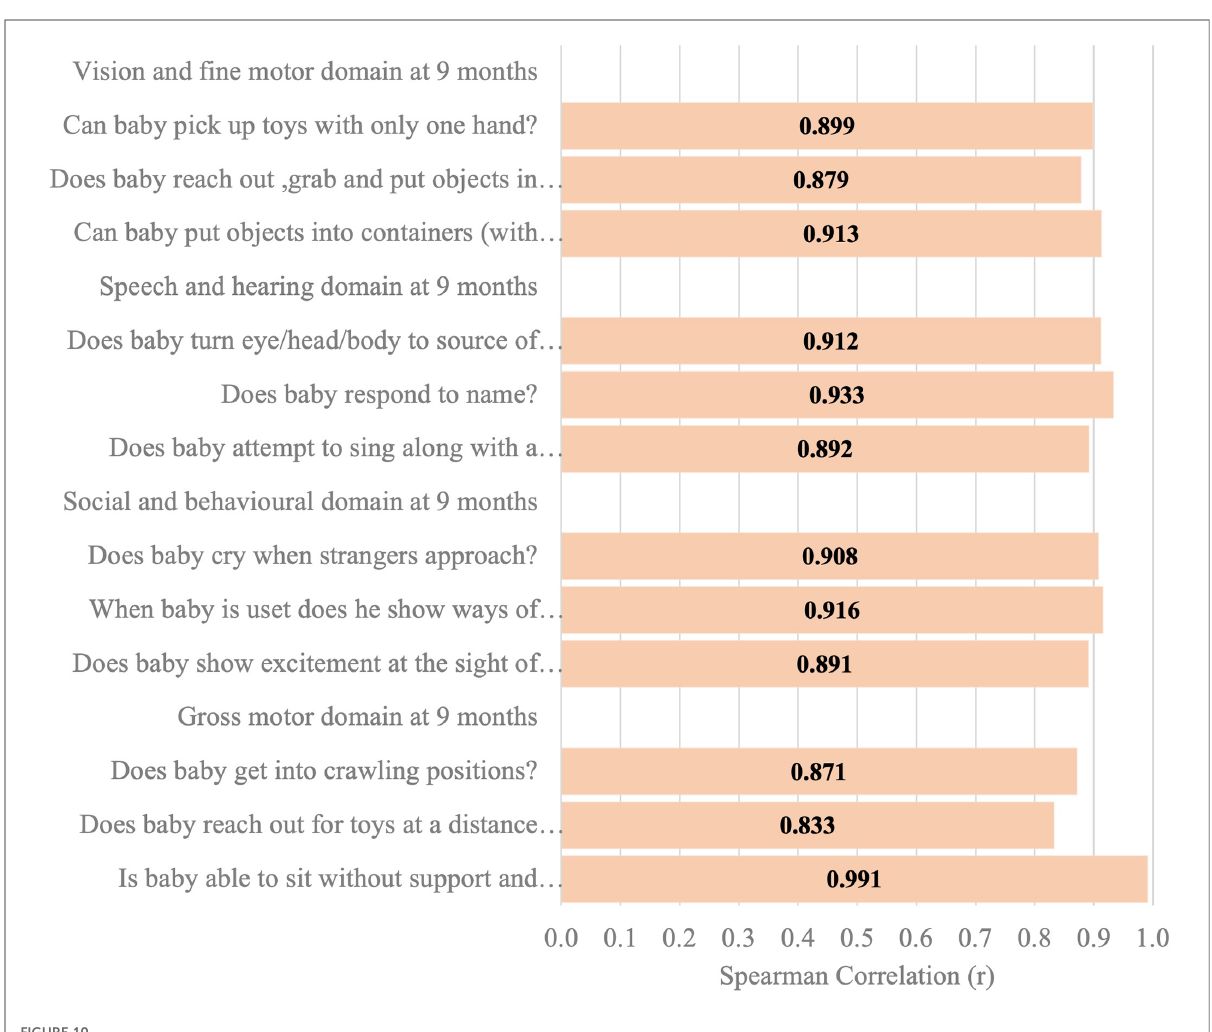
FIGURE 10 Spearman correlation coef fi cient of the ISDS scores of two assessors of the same participants aged 9